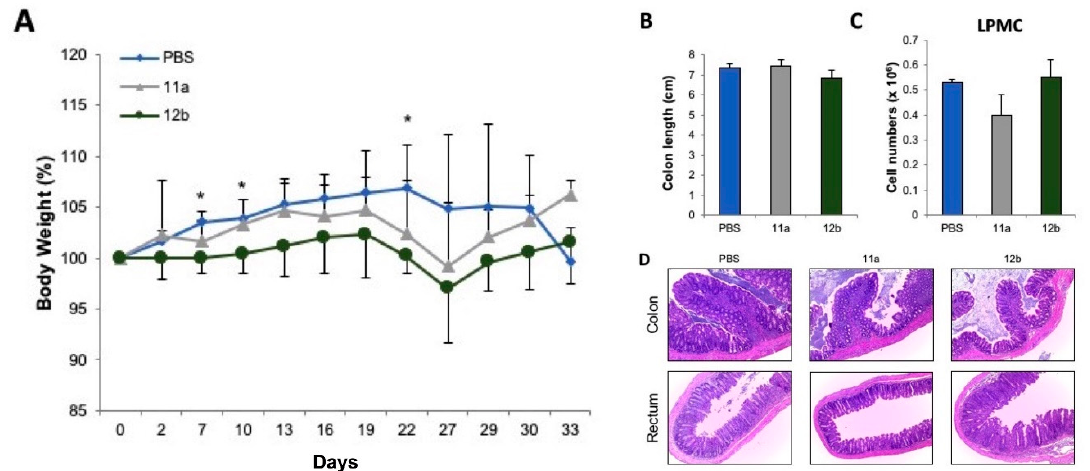
Figure 7. ES-62 SMAs do not attenuate T cell transfer colitis in mice. Naïve CD4 + T cells from wild type (WT) mice were injected into Rag1 − / − mice. PBS or SMAs (11a, 12b) were injected twice per week. ( A ) Body weight changes as a percentage of the initial weight at day 1. ( B ) Colon length. ( C ) Total cell counts in lamina propria mononuclear cells. ( D ) Representative H & E staining of colons at the time of sacrifice. Magnification = 100 × . For ( A – C ) data represent means ± SD. N = 5/group. * p < 0.05 as determined by Student’s t -test for comparisons between PBS- and 12b-treated mice.